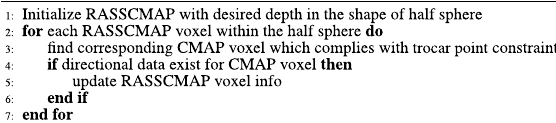
Algorithm 1. RASSCMAP with Minimum